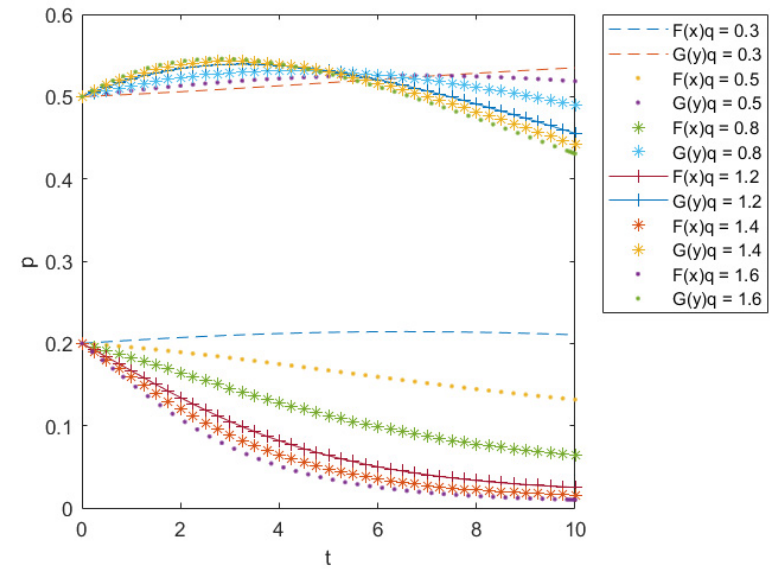
Figure 4. E ff ect of reward q changes on evolutionary outcomes. Figure 4. Effect of reward q changes on evolutionary outcomes.